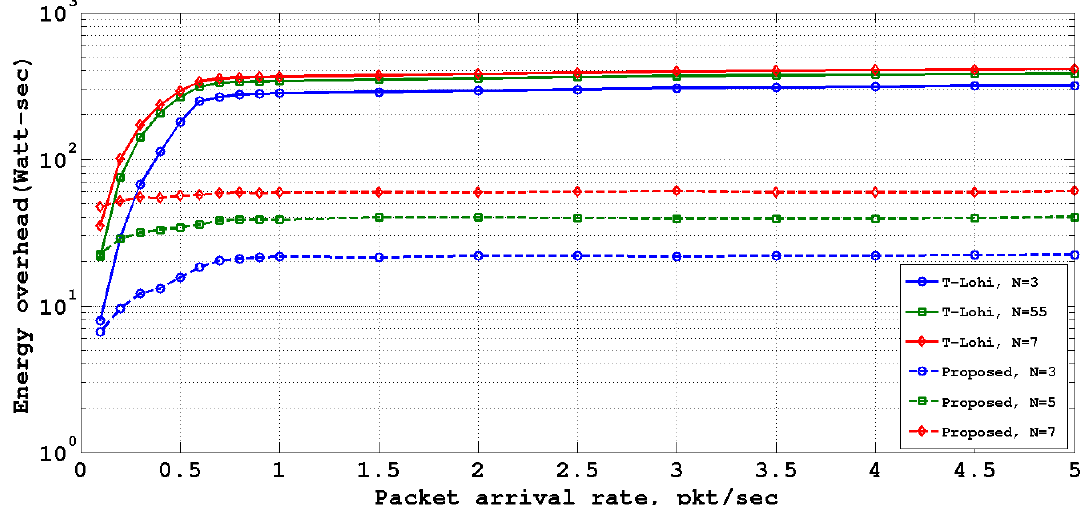
Figure 12. Comparison of energy overhead between T-Lohi and the proposed